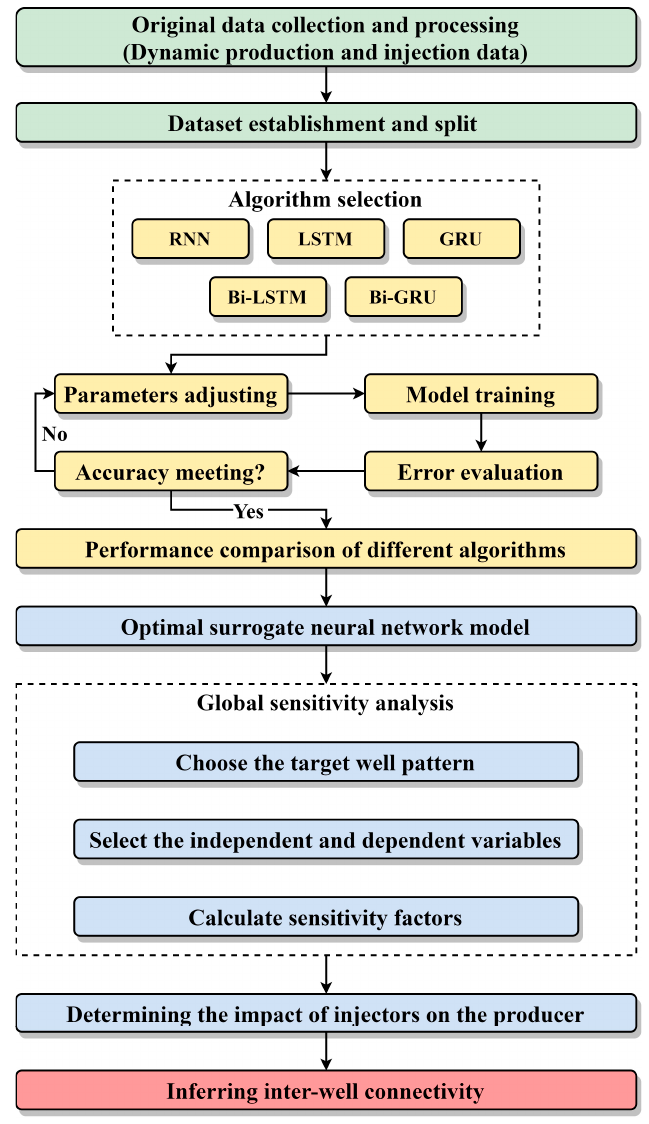
Figure 2. Work fl ow of the proposed method. Figure 2. Workflow of the proposed